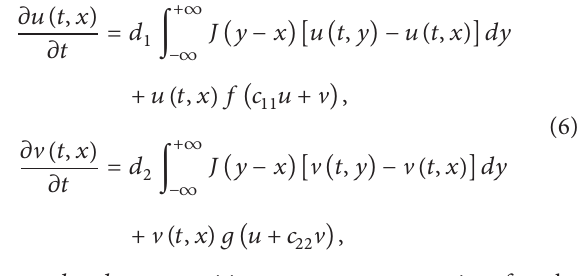
Figure 1: Typical fitness functions for pioneer species and climax